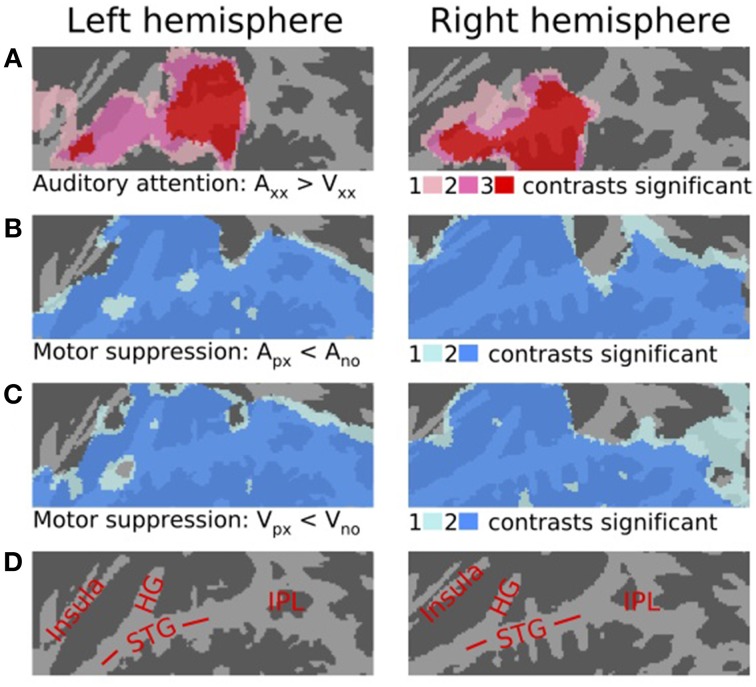
The effects of auditory attention and motor responding on activations to sounds shown on a flattened mean 2D cortical surface (N = 16, corrected P < 0.05). (A) The areas where activations were enhanced during the auditory task as compared with visual task with identical stimuli and motor responses. The results of three separate contrasts (Apr > Vpr, Apo > Vpo, Ano > Vno) are plotted so that areas where any one of the contrasts was significant are shown in pink and areas where all three contrasts were significant are shown in red. (B) Motor suppression during the auditory tasks. The results of two contrasts (Apr < Ano, Apo < Ano) are plotted so that areas where either of the contrasts was significant are shown in light blue and areas where both contrasts were significant are shown in darker blue. (C) Motor suppression during the visual task (Vpr < Vno, Vpo < Vno). (D) Anatomical labels: STG, superior temporal gyrus; HG, Heschl's gyrus; PT, planum temporale; IPL, inferior parietal lobule.